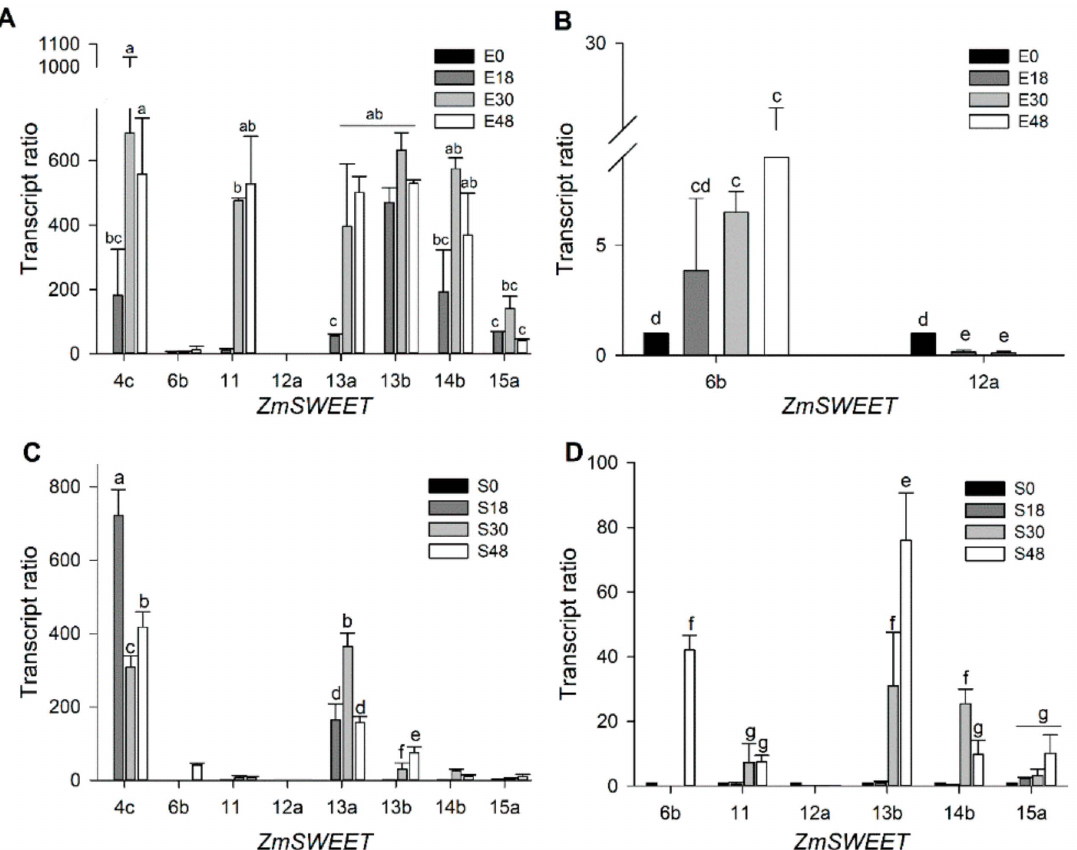
Figure 2. ZmSWEET mRNA levels profile in ( A , B ) the embryo axis and ( C , D ) the scutellum at di ff erent hours of germination. To visualize the transcript amount of SWEETs that change during germination but that are poorly represented in the tissue, ( B ) and ( D ) show the data at a lower scale than ( A ) and ( C ). The transcript ratio was calculated according to the Pfa ffl method [30], normalizing with the invariant housekeeping gene Zm18s and the mRNA level of each ZmSWEET from tissues that were obtained from non-germinated seeds (0 h). Bars represent the average of two technical replicates from two independent experiments ± SD. Di ff erent letters indicate statistically significant values according to the Tukey test, p <